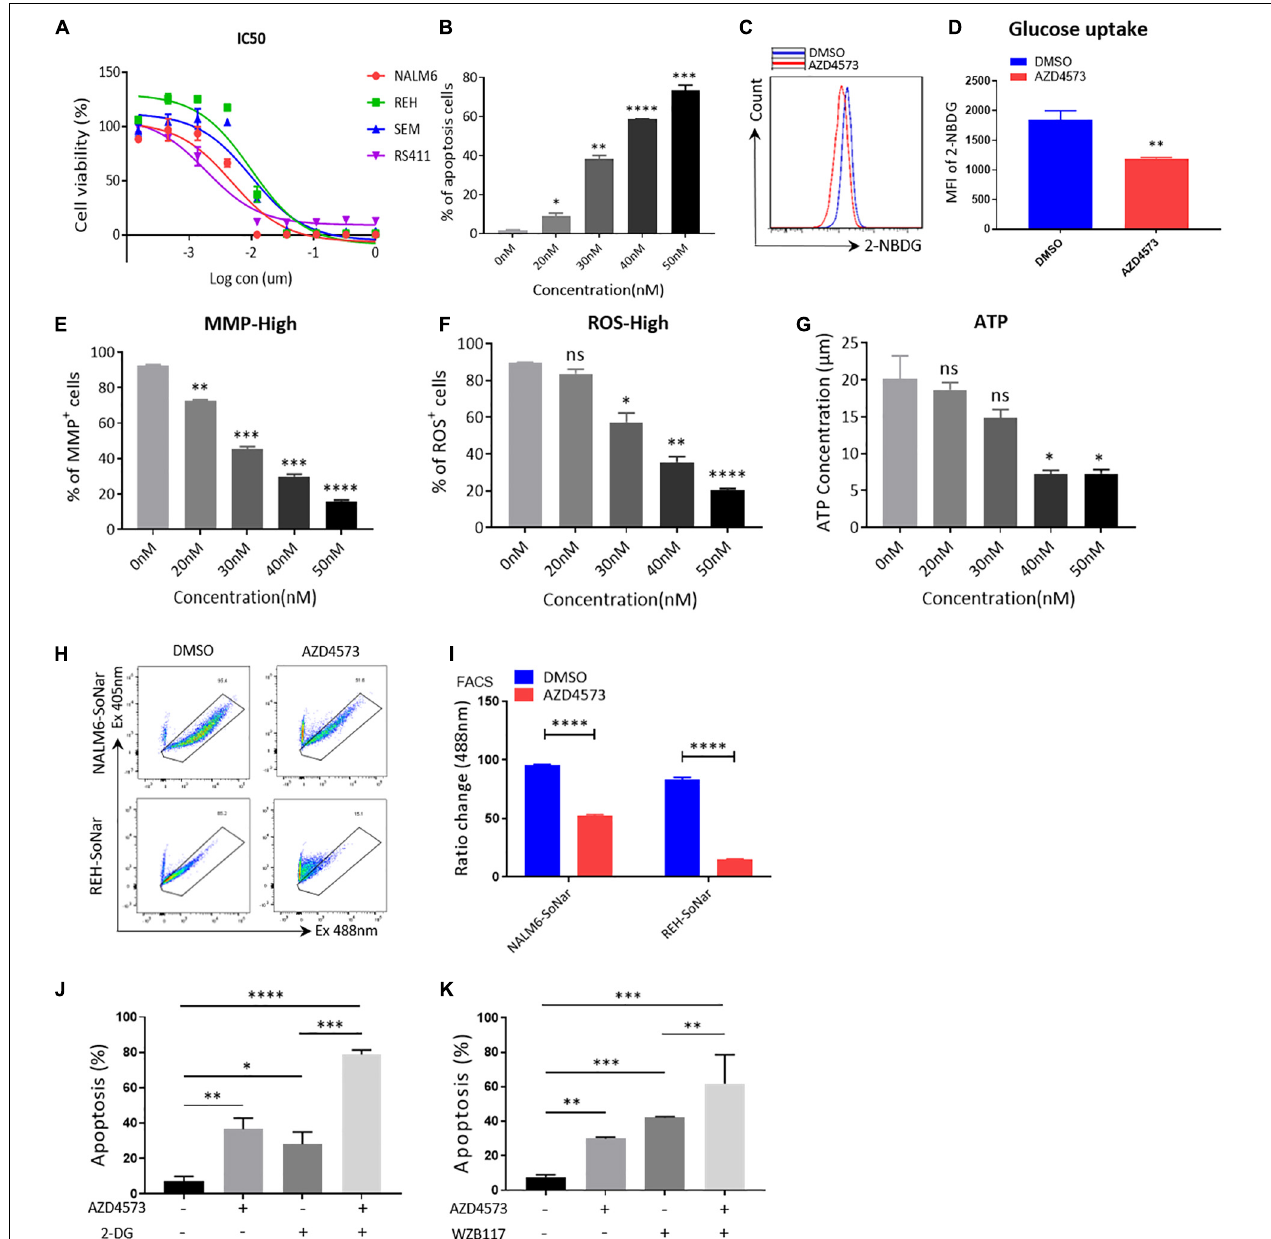
FIGURE 4 | AZD4573 treatment results in the cell death of B-ALL cell lines. (A) Drug sensitivity assay of NALM6, REH, SEM, and RS411 cell lines. B-ALL cells were treated with a gradient concentration of AZD4573 for 72 h. (B) Annexin V- and PI-labeled cell apoptosis of REH cells was analyzed by flow cytometry. (C) The glucose uptake of REH cells was detected by flow cytometry. (D) Statistical analysis of glucose uptake of REH cells. (E,F) MMP and total ROS of REH cells was analyzed by flow cytometry. (G) The quantification of intracellular ATP in B-ALL cells was assessed using the ATP determination kit. (H) The SoNar-low or -high cells of B-ALL cells were measured by flow cytometry with 405 and 488 nm excitation. (I) Statistical analysis of SoNar-high B-ALL cells. (J,K) Cell apoptosis of AZD4573-treated NALM6 cells analyzed by flow cytometry after co-treatment with 2-DG (1 mM) and WZB117 (10 nM) for 24 h. B-ALL cells were treated with AZD4573 for 24 h. Values were shown as mean ± SEM. ∗ p < 0.05, ∗∗ p < 0.01, ∗∗∗ p < 0.001 and ∗∗∗∗ p <